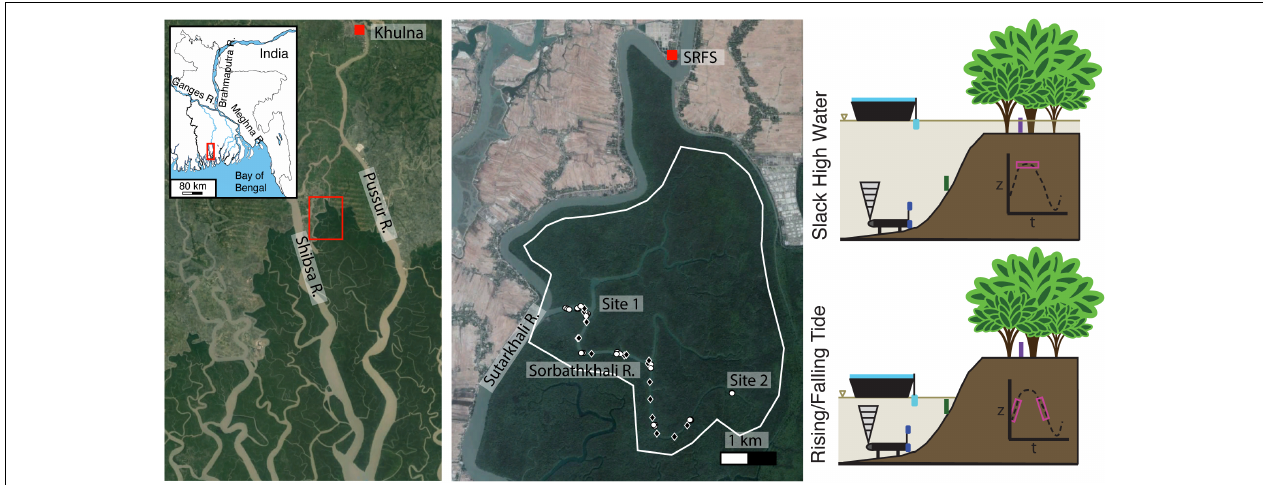
FIGURE 1 | Satellite images of the study area, highlighting the Sundarbans mangrove forest (dark green) and representative sub-basin (red box) located proximal to the heavily modified polder region (light green-tan). Middle image is a zoom of the sub-basin, highlighting the location of the long-term sensors at the Suterkhali Reserve Forestry Station (SRFS), Sites 1 and 2 where single-day measurements were made seasonally, and sediment grab locations for the wet (diamond) and dry (circle) seasons. An approximate boundary for this sub-basin is sketched in white. Right-hand panel depicts the experimental design at Sites 1 and 2, demonstrating the relative locations of the ADCP measurements (gray triangle), channel-bottom measurements (blue), channel-surface measurements (cyan), channel-bank velocities (green), and platform measurements (purple). Satellite imagery via (Google Earth, 2015,